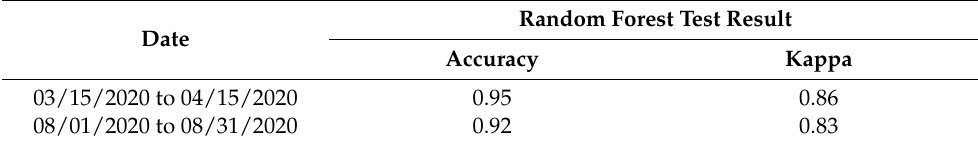
Table 7. Summary of testing classification methods.